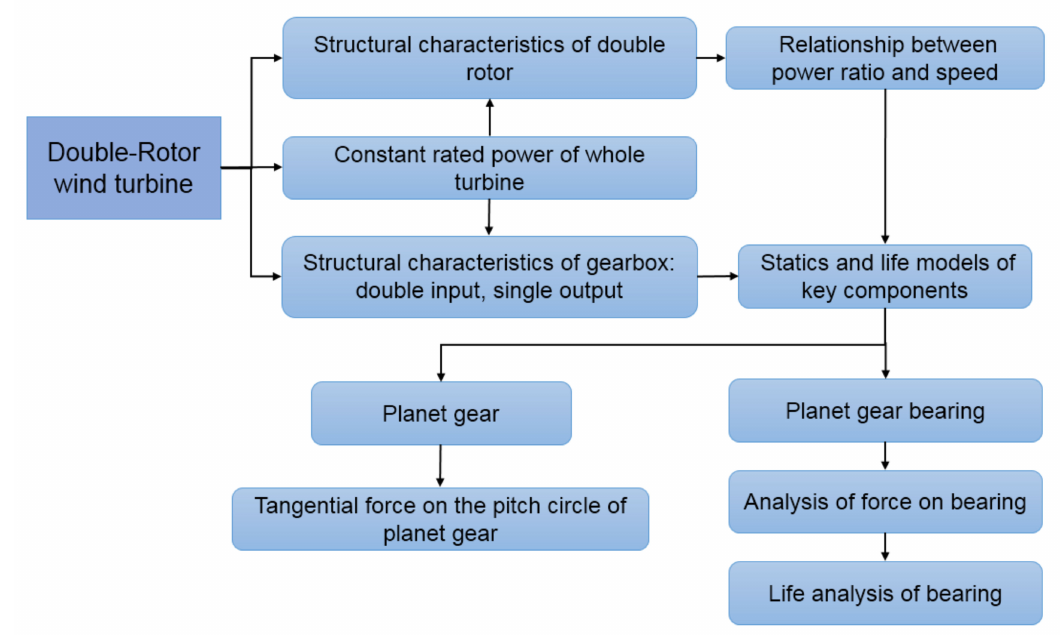
Figure 1. The organization of the